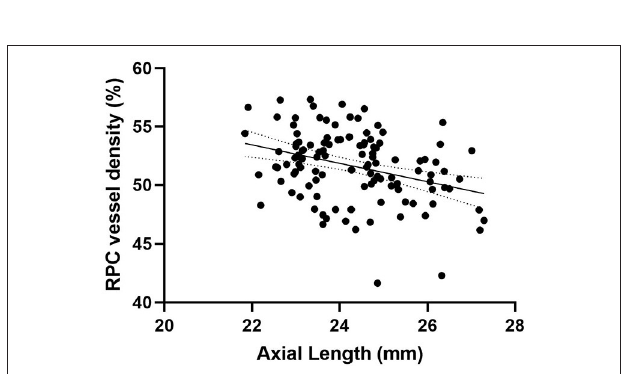
FIGURE 3 | Correlation matrix performed by spearman analysis between Axial length and RPC vessel density ( r = − 0.317, p < 0.001).